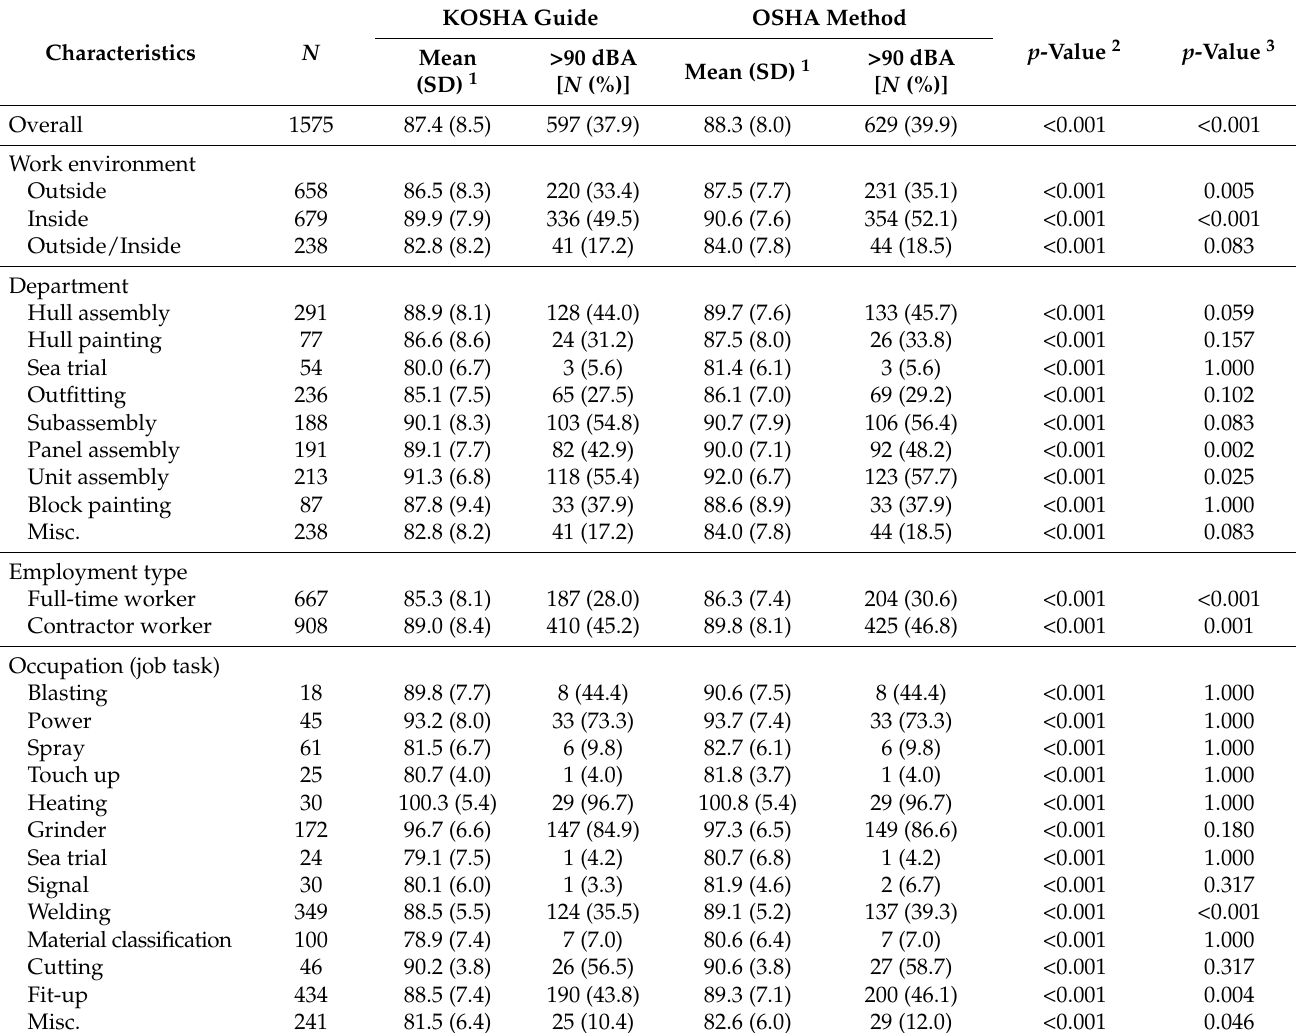
Table 5. Comparison of the mean noise exposure levels by KOSHA and OSHA method (when excluding break time, 8 h).